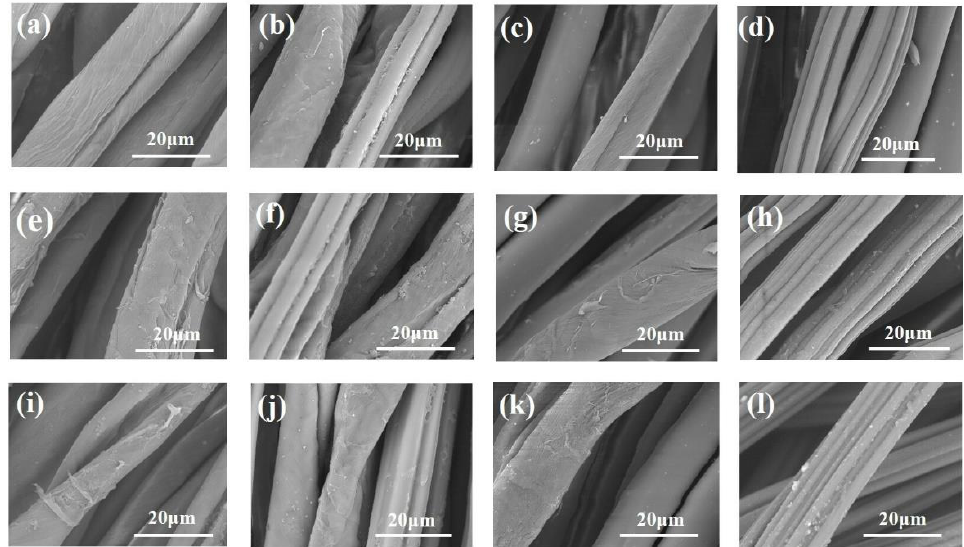
Figure 7. SEM images of original and treated fabrics. ( a – d ) original C, C/V, T/C and T/V fabrics; ( e – h ) treated C, C/V, T/C and T/V fabrics with the dipping process; ( i – l ) treated C, C/V, T/C and T/V fabrics with the pad–dry–cure process.